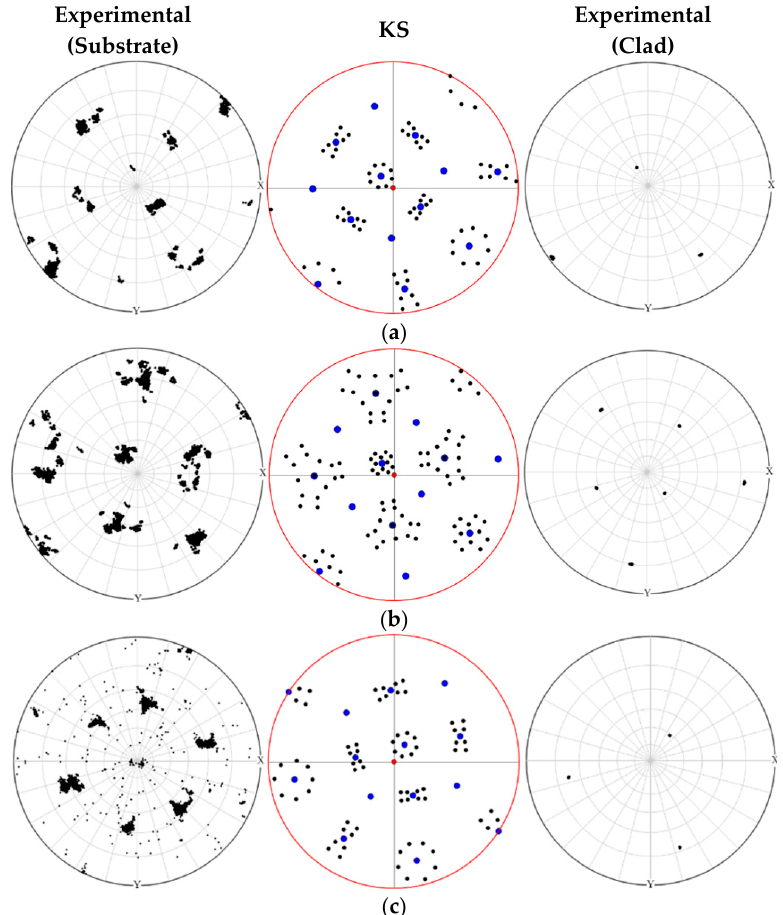
Figure 8. Pole figures of the grains of the heat affected zone of the substrate and the clad near the fusion line: ( a ) experimentally obtained martensite transformation variants in (100) plane (left), the 24 possible variants obtained based on the Kurdjumov-Sachs relationship (middle), and the clad grain crystallographic orientation (right); ( b ) same as ( a ), but in (110) plane; and ( c ) PF for the grains with boundary type II in (100)